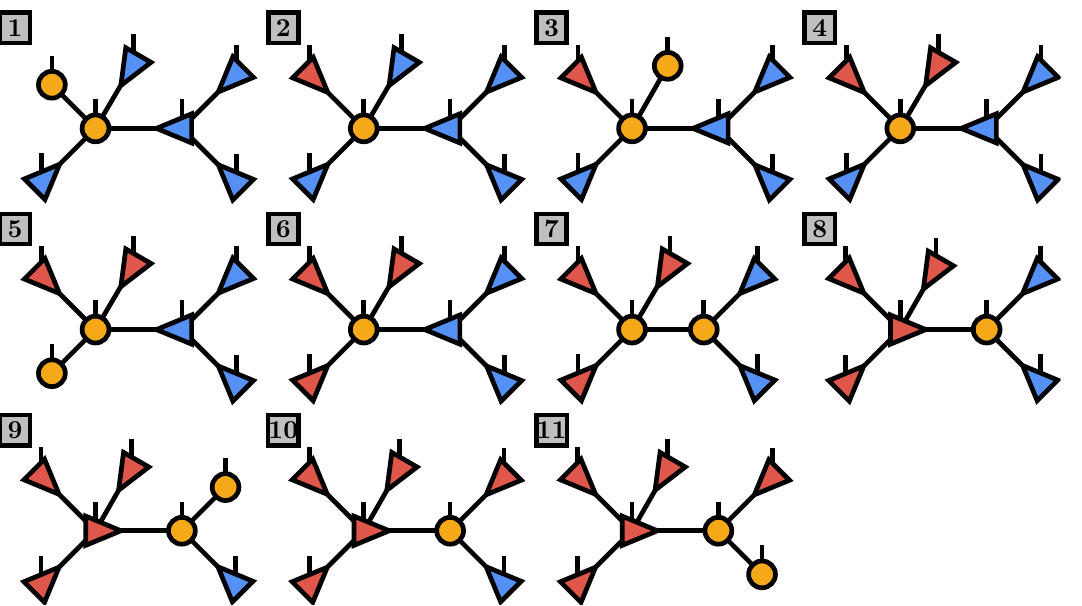
Figure 8: Update sequence to perform a first-order two-site TDVP time step from time t to t + ∆ t for the TTN shown in Fig. 1. Start point is site 1 and end point site 7. Yellow denotes tensors that are updated in the current step. Red and blue tensors indicate whether this tensor is taken at time t + ∆ t (red) or t (blue). Triangles indicate the orthogonalization of each tensor. Updates on two-site tensors are in forward direction (negative sign), while updates on a single site are backwards time evolutions (positive sign in Eq. 17). For a second-order update, first perform all steps ( 1 ) → ( 11 ) with time step dt in the order shown and then reapply them in the reverse 2 order ( 11 ) → ( 1 ) , again with time step dt 2